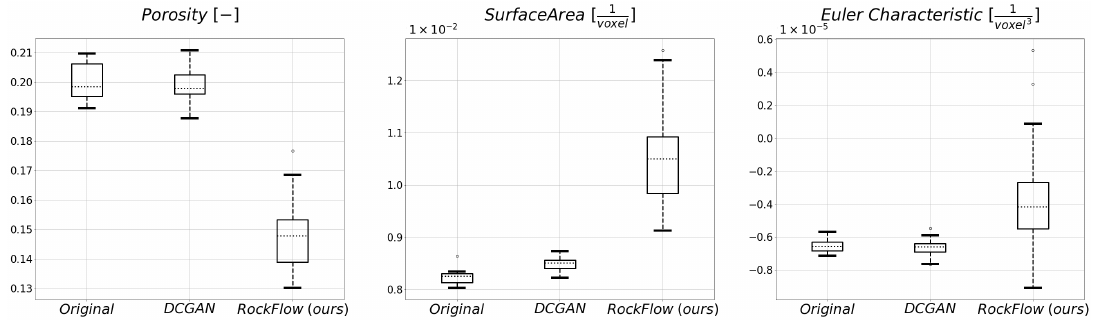
Figure 7. Comparison of Minkowski functionals among ground-truth images, DCGAN model, and the presented generative flow model for Berea sandstone images for (left) porosity, (middle) surface area, and (right) Euler characteristic. The ground-truth and DCGAN data were evaluated on 200 3 image volumes and taken from [3]. The generative flow model was evaluated on 128 3 image volumes.